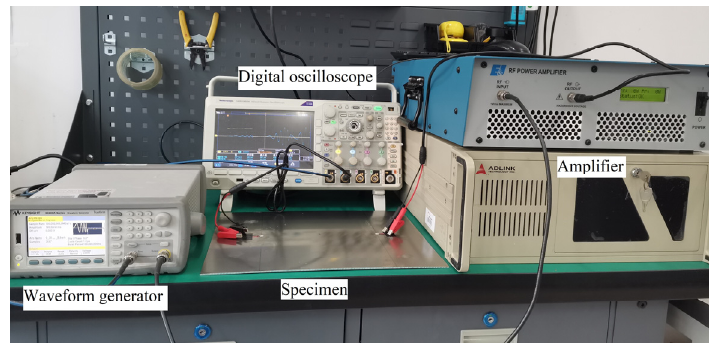
Figure 15. Experimental setup for coupon test.